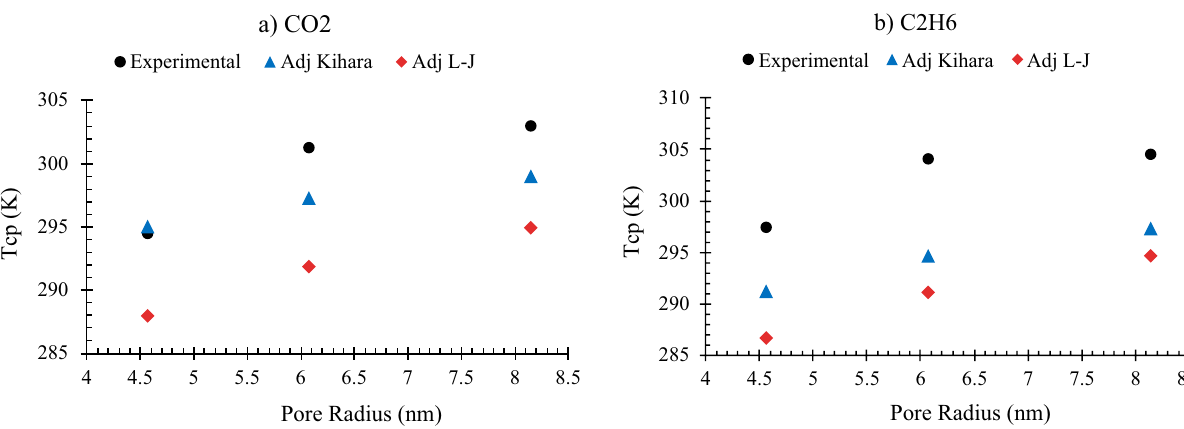
Pore Radius (nm) Figure 9. Comparison among the T cp values from experimental reports 4 as well as the predictions of adjusted Kihara and adjusted L-J methods for ( a ) carbon dioxide and ( b )